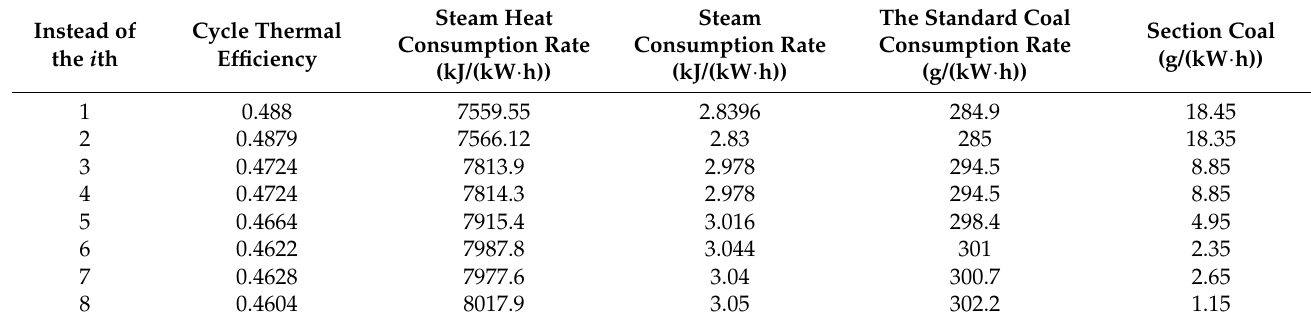
Table 2. 600 MW SAPG system thermal economy under non-variable conditions.